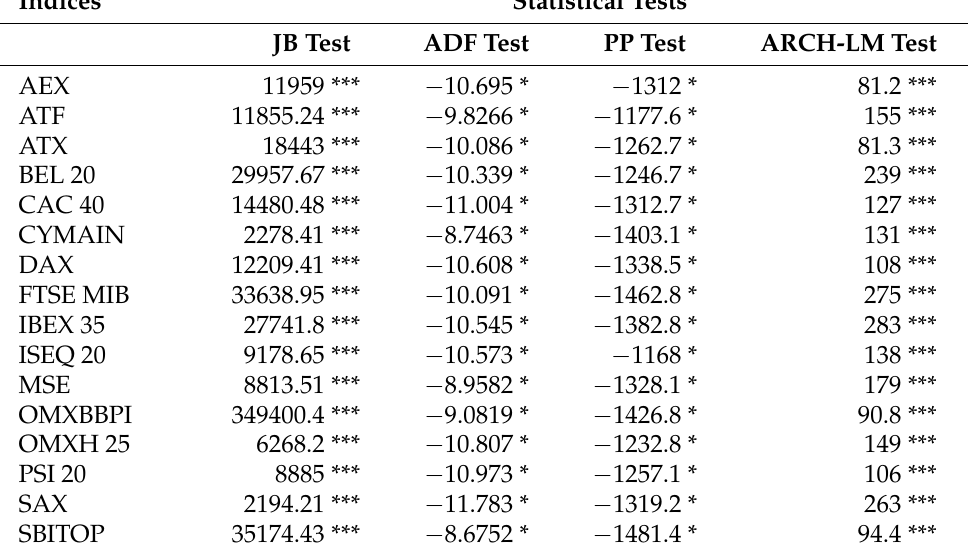
Table A2. Statistical Tests